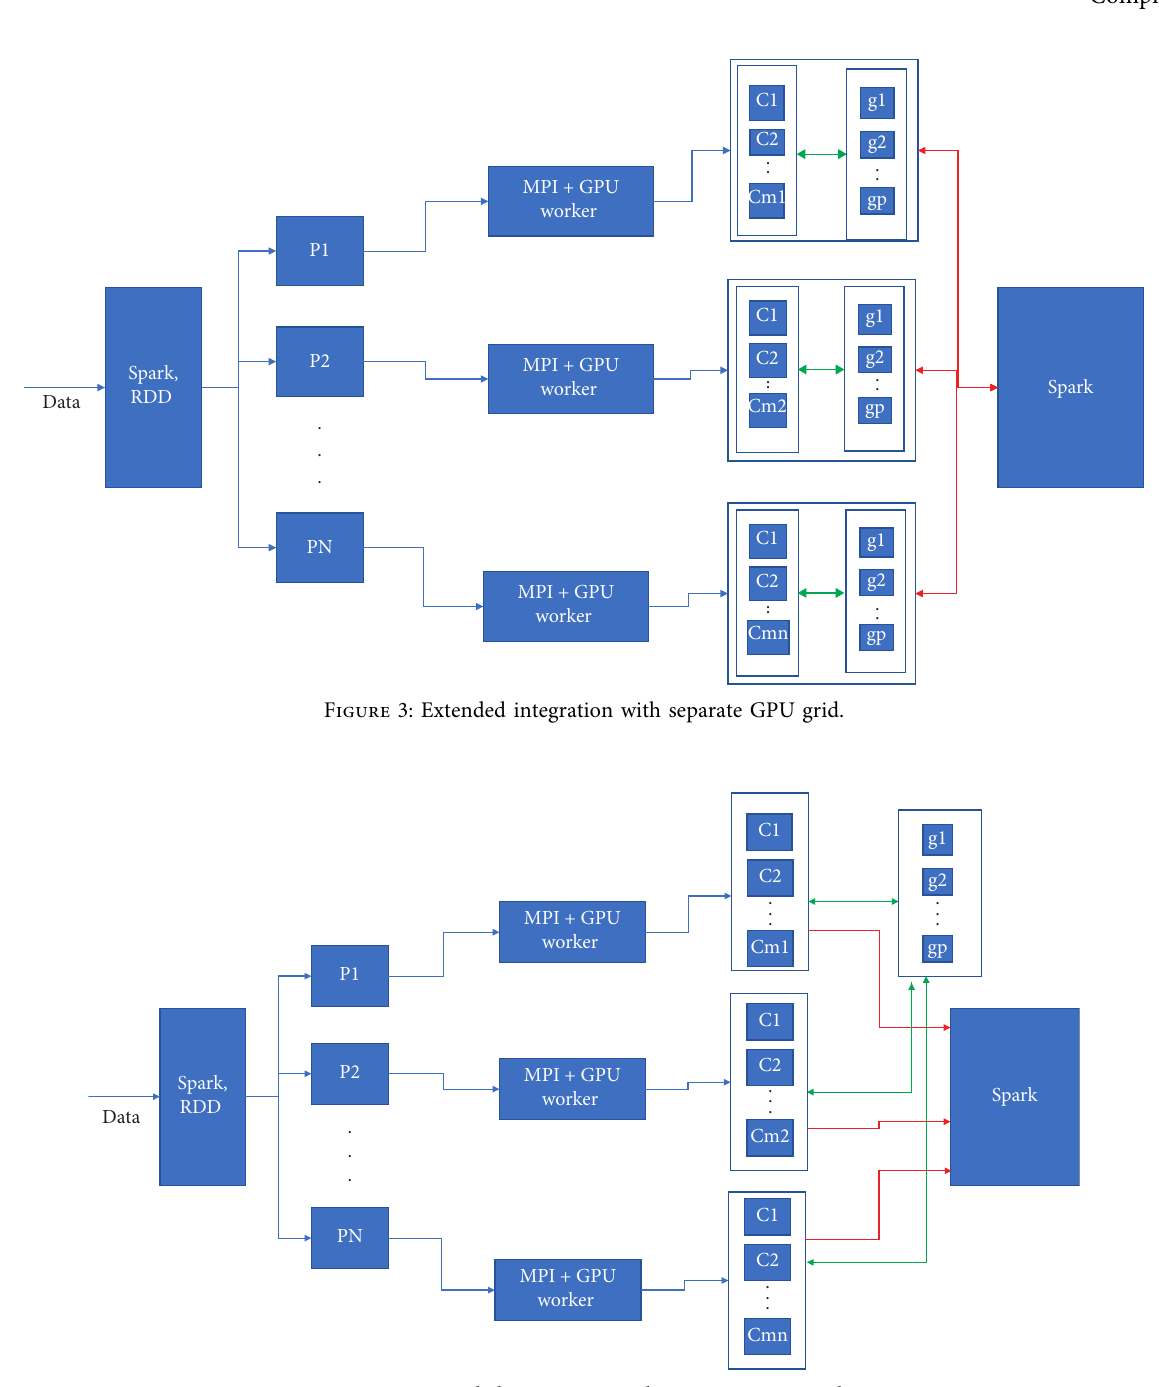
Figure 4: Extended integration with common GPU grid.